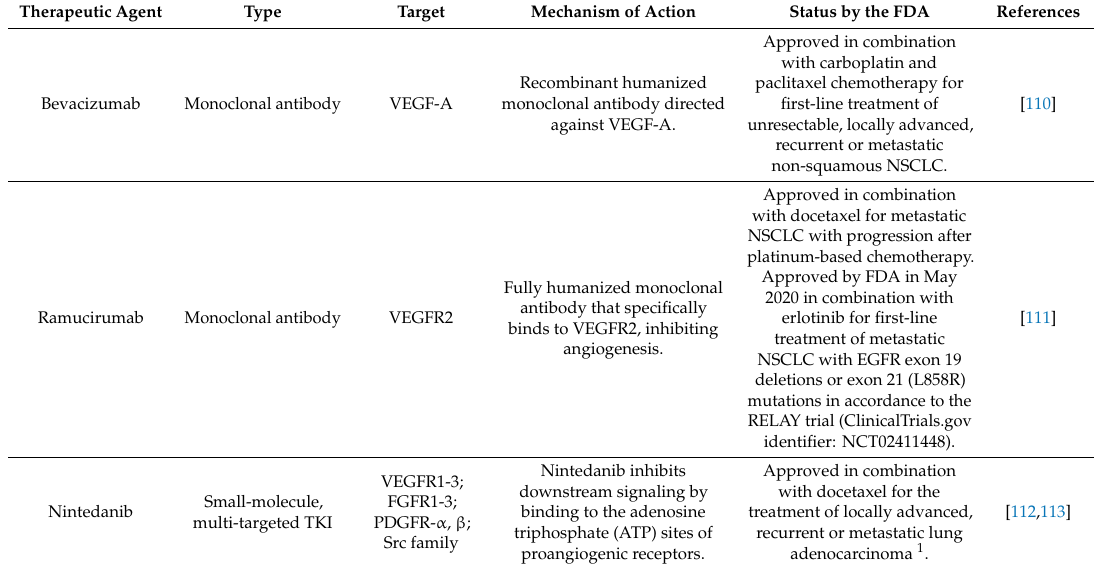
Table 3. Therapeutic agents that target the angiogenic process in lung cancer. Status by the FDA refers to approval in